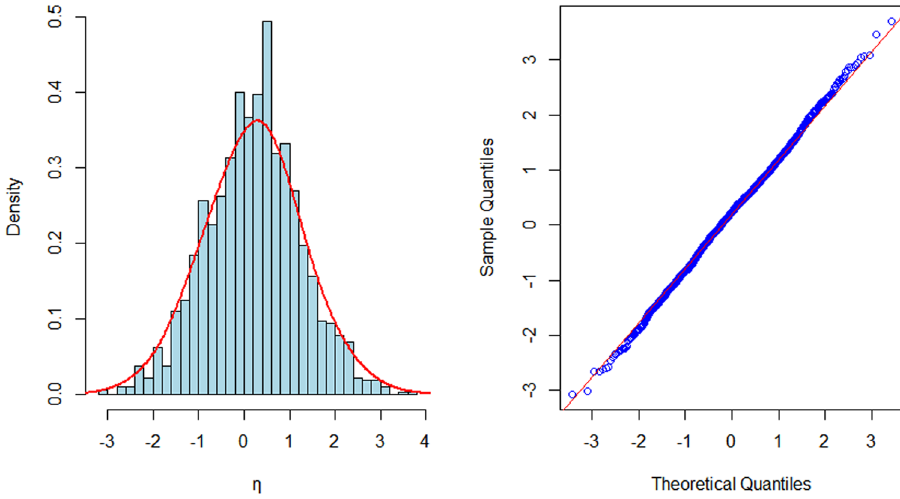
Figure 6: Histogram and normal Q – Q plot of